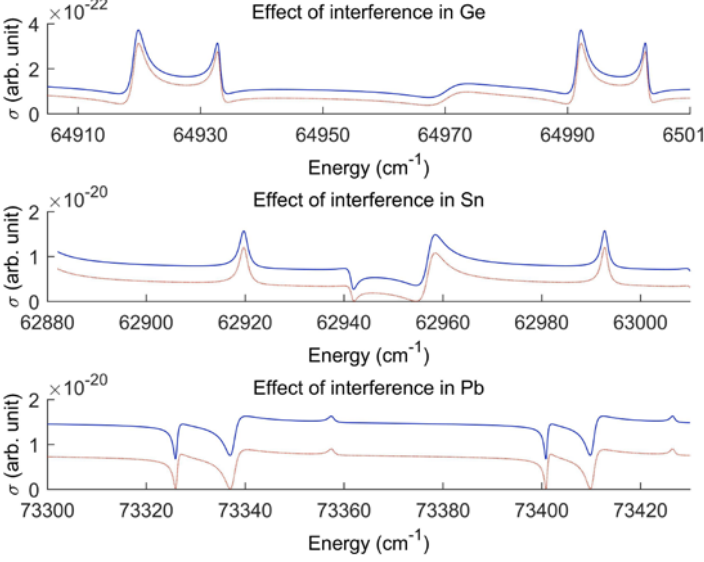
Figure 14. Comparison of the cross sections calculated without any approximation using the experimentally obtained multichannel quantum defect theory (MQDT) parameters plotted as a dotted line and the one obtained from the sum of the Beutler-Fano terms without including interference terms plotted as a solid line. Therefore, the difference between the two curves in each spectrum is due mainly to interference (from [29]).